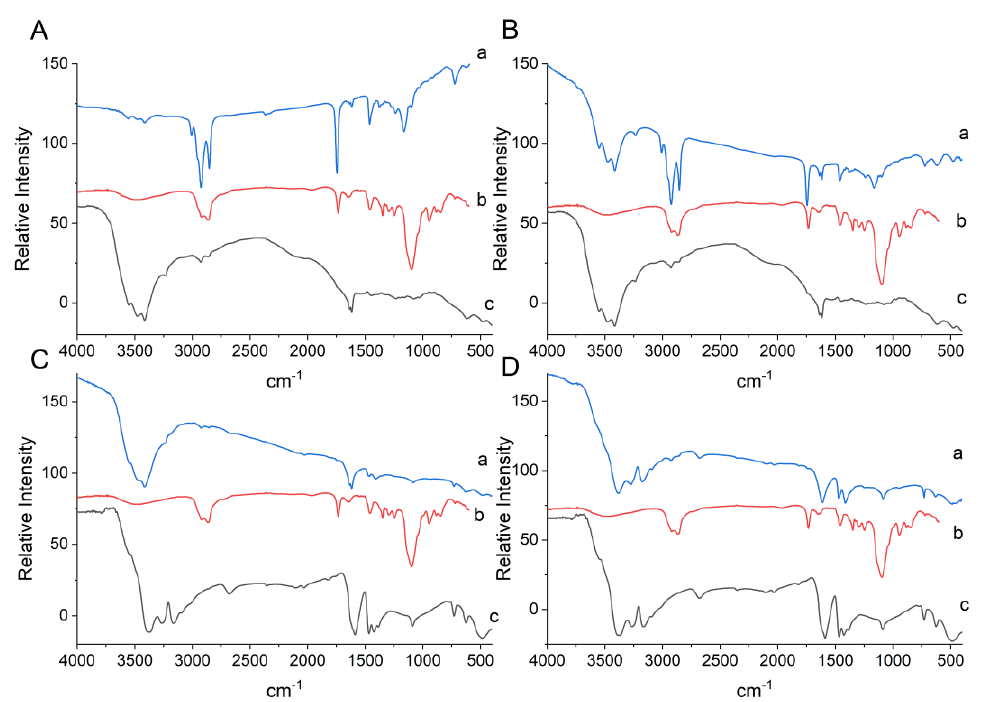
Figure 2. FTIR spectra of the encapsulates obtained by O/W emulsification. ( A ) LAEG — L. acidophilus in gelatin ( a ); Tween 20 ( b ); porcine gelatin ( c ). ( B ) LPEG — L. plantarum in gelatin ( a ); Tween 20 ( b ); porcine gelatin ( c ). ( C ) LAEA – L. acidophilus in alginate ( a ); Tween 20 ( b ); alginate ( c ). ( D ) LPEA — L. plantarum in alginate ( a ); Tween 20 ( b ); sodium alginate ( c ). Characteristic bands in the formulation LAEG (Figure 2A) were observed at 3008 cm − 1 , referring to dimers of secondary amides (NH) in s-cis or s-trans conformations [32], at 1235 cm − 1 for phosphate-bearing compounds, and at 1162–916 cm − 1 attributed to microbial